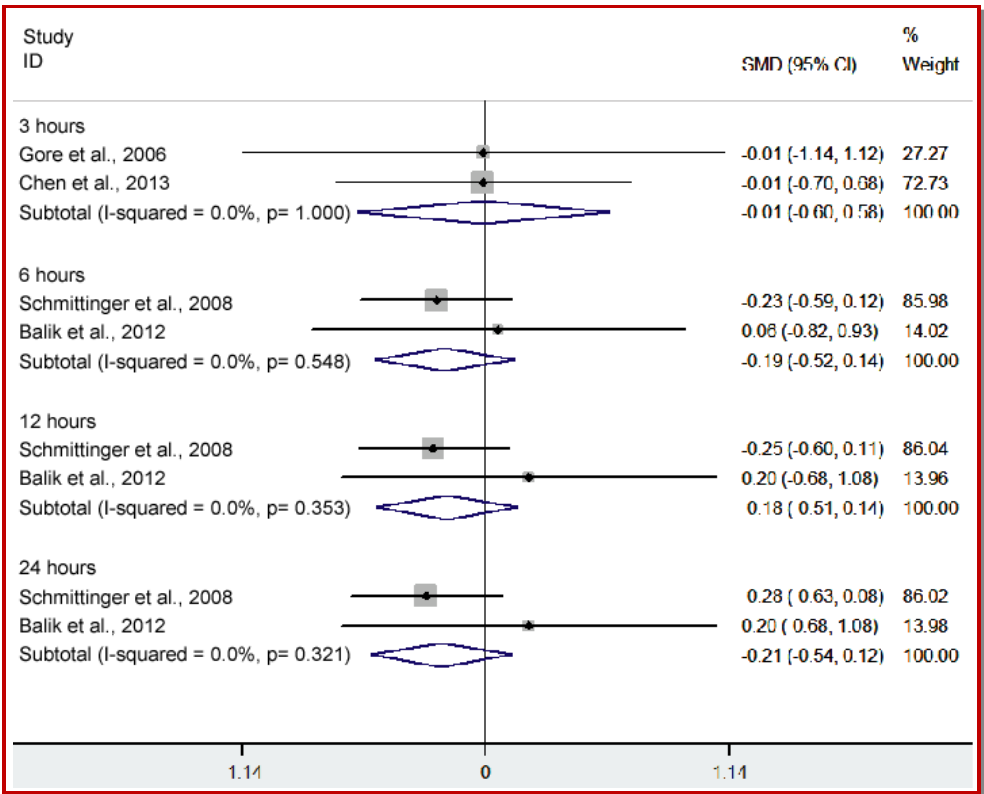
Figure 8: Meta-analysis of β -blocker on the systemic vascular resistance index (digit within the parenthesis means the number of studies for